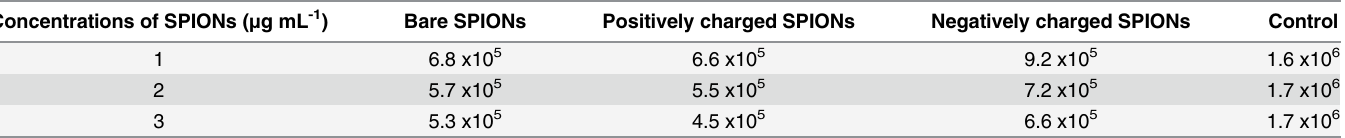
Table 3. CFU values (/mL) for S . mutans isolated from biofilms that were either exposed to bare, positively charged or negatively charged SPIONs or were incubated in the absence of SPIONs. Concentrations of SPIONs ( μ g mL -1